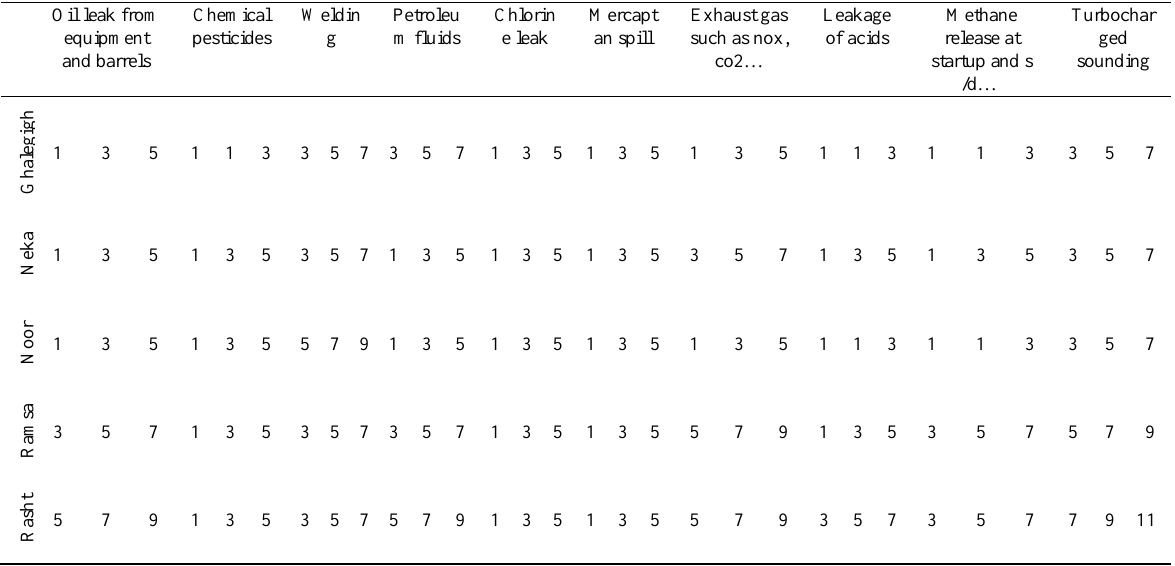
Tables 13. Results of the fuzzy questionnaire for environmental criteria relative to gas facility.